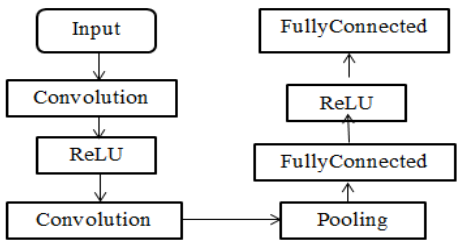
Figure 3. Block Diagram for LeNet-5 Operation.